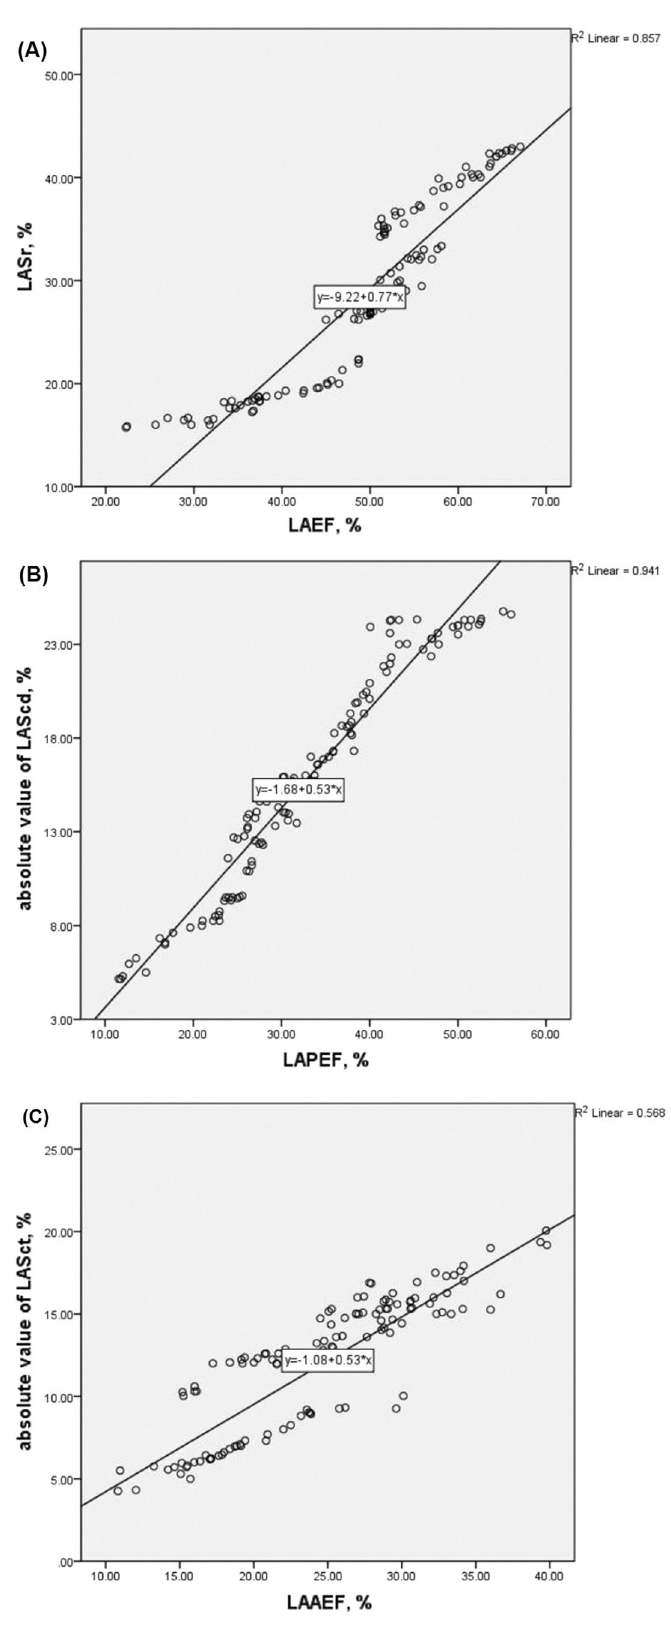
Figure 4. Linear correlations between LA strain parameters and the parameters of traditional LA function. Linear correlation between LASr and LAEF ( A ). Linear correlation between absolute value of LAScd and LAPEF ( B ). Linear correlation between absolute value of LASct and LAAEF ( C